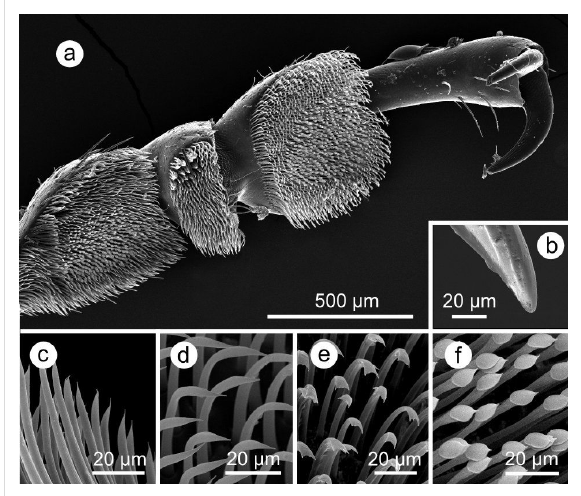
Figure 3: SEM micrographs of the attachment devices in a male Lept- inotarsa decemlineata . (a) Ventral view of a hind leg; (b) claw tip; (c–f): Tarsal adhesive setae: (c) filamentous, (d) lanceolate, (e) spatula- shaped and (f) discoidal setae. Terminology according to Voigt et al. [13]. Adapted from